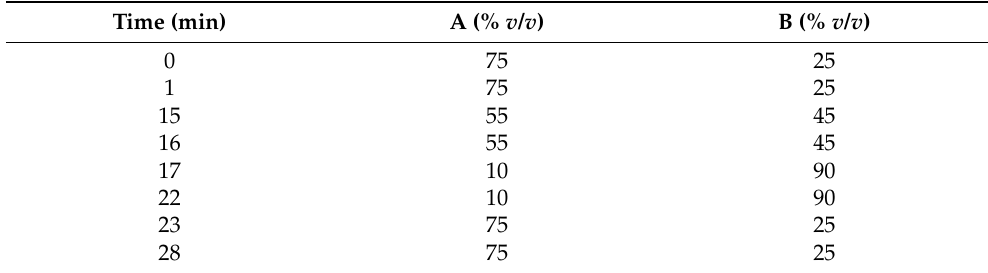
Table 2. Gradient mobile phase elution for icariin determination in Epimedium L. (Species: Epimedium Koreanum ) extract via